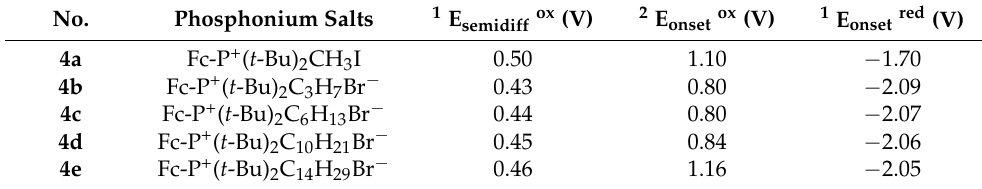
Table 3. Electrochemical properties of Fc-containing phosphonium salts 4a – 4e . Conditions: Room temperature, Working Electrode: Glass-carbon, vs. Ag/AgCl. Solvent CH 3 CN.